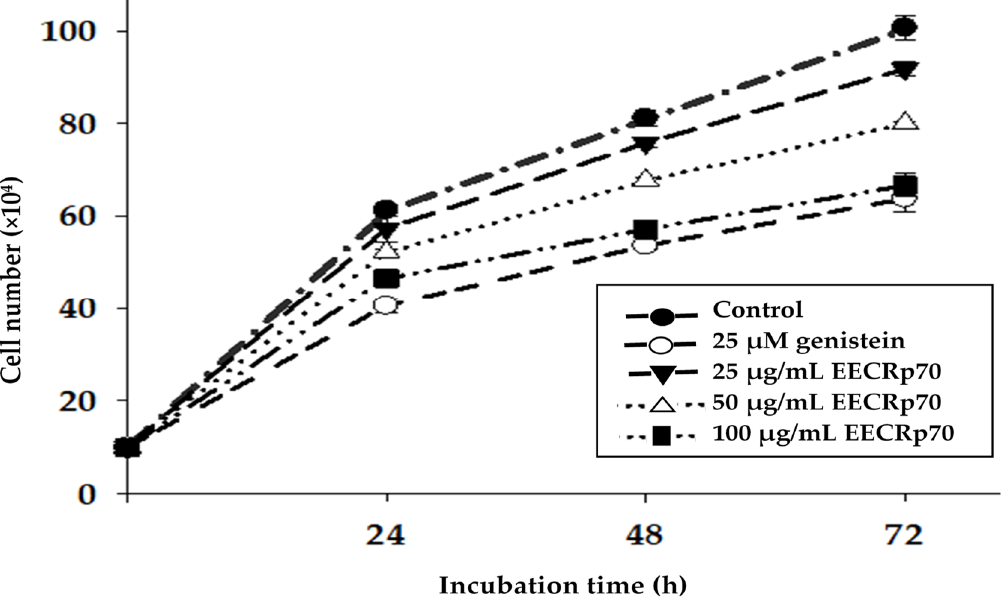
Figure 4. Effects of EECRp70 on anti-proliferation of SCC25 cells. Cells were treated with (0–100 µg/mL) EECRp70 for 24, 48, and 72 h. The number of viable cells was determined by the trypan blue exclusion method using a hemocytometer: 25 µM genistein (6.8 µg/mL genistein) and 100 µg/mL EECRp70 (10.2 µg/mL genistein). Results were expressed as (mean ± SD, n = 3, p < 0.05).